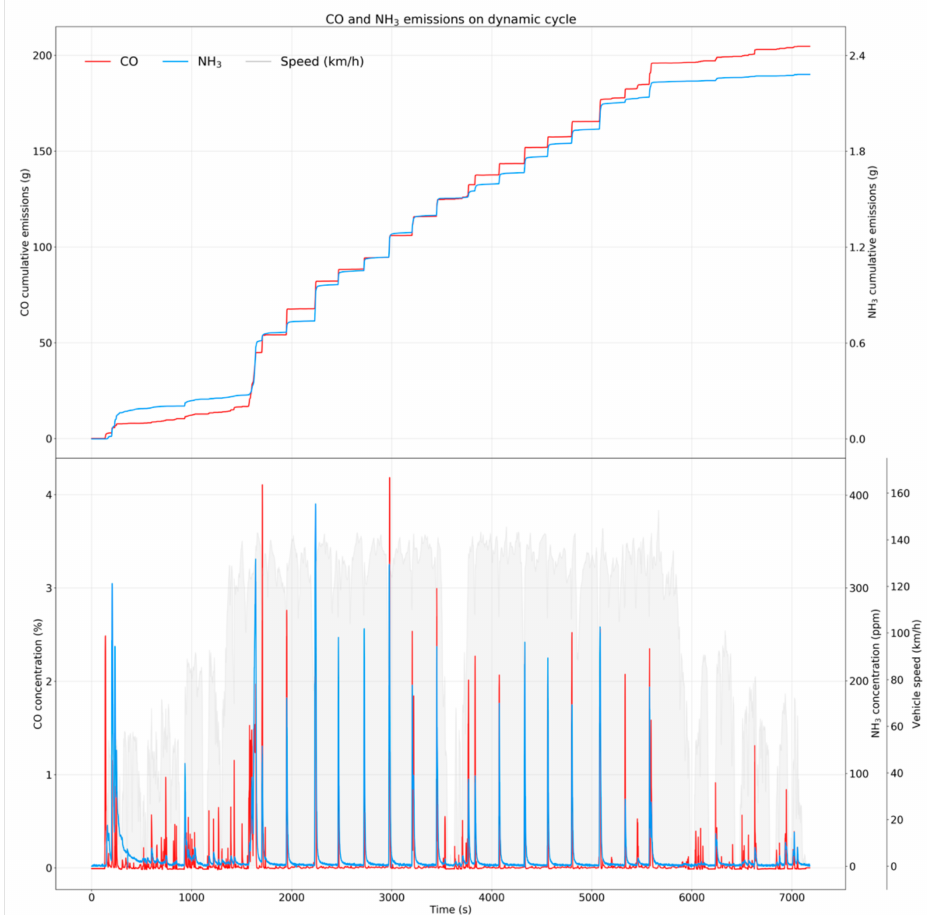
Figure 6. CO and NH 3 emissions on a dynamic motorway test on-road. The test was performed with an initial state of charge (SOC) equal to the minimum and the default user-selectable mode. Upper panel reports cumulated emissions of CO (red line) and NH 3 (blue line). Lower panel reports instantaneous tailpipe concentrations of CO (red line, measured with conventional PEMS) and NH 3 (blue line, measured with p-FTIR) as well as the speed profile of the cycle (gray). See the Methods section for additional